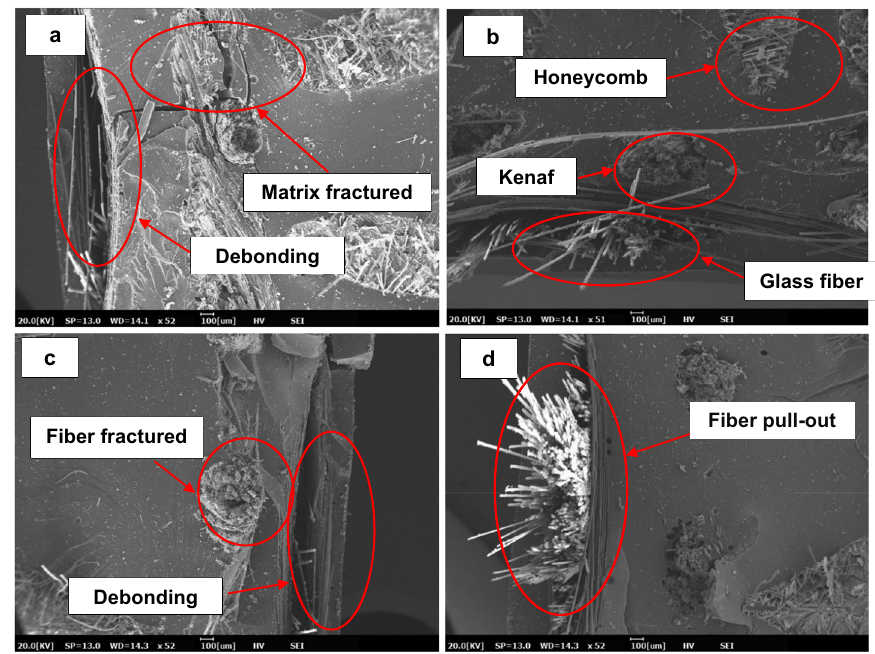
Figure 5: SEM micrographs of glass - kenaf - honeycomb composite at di ff erent magni fi cations showing ( a ) matrix cracking between glass and kenaf fi ber ( b ) good adhesion between fi bers and matrix ( c ) debonding of the glass fi ber ( d ) fi ber pull - out of the glass fi ber.